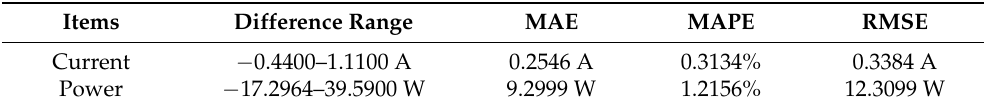
Table 3. Accuracy analysis of PVEFD